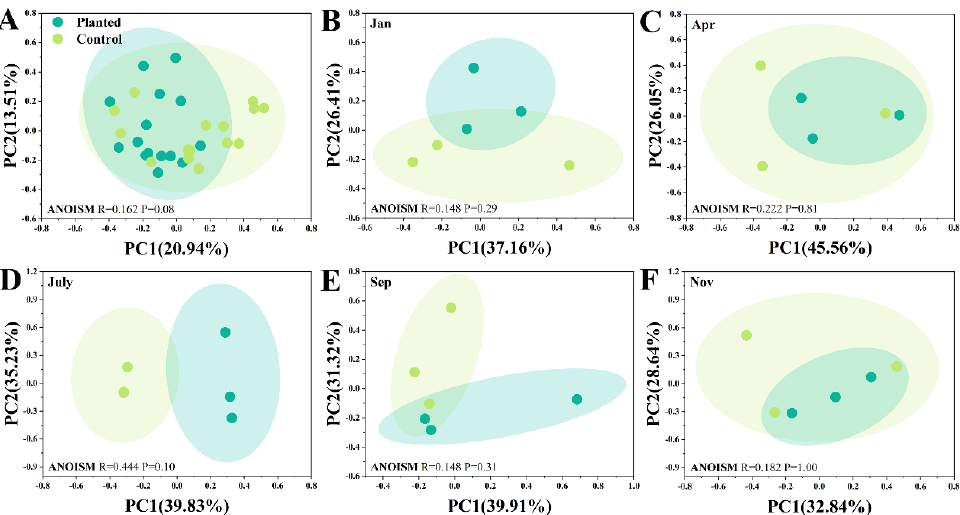
Figure 4. The PCoA analysis of the AMF community’s composition on the OTU level: ( A ) depicts annual differences between the planted and control groups, while ( B – F ) depict each sampling time. A p < 0.05 indicates a significant difference between the two groups.